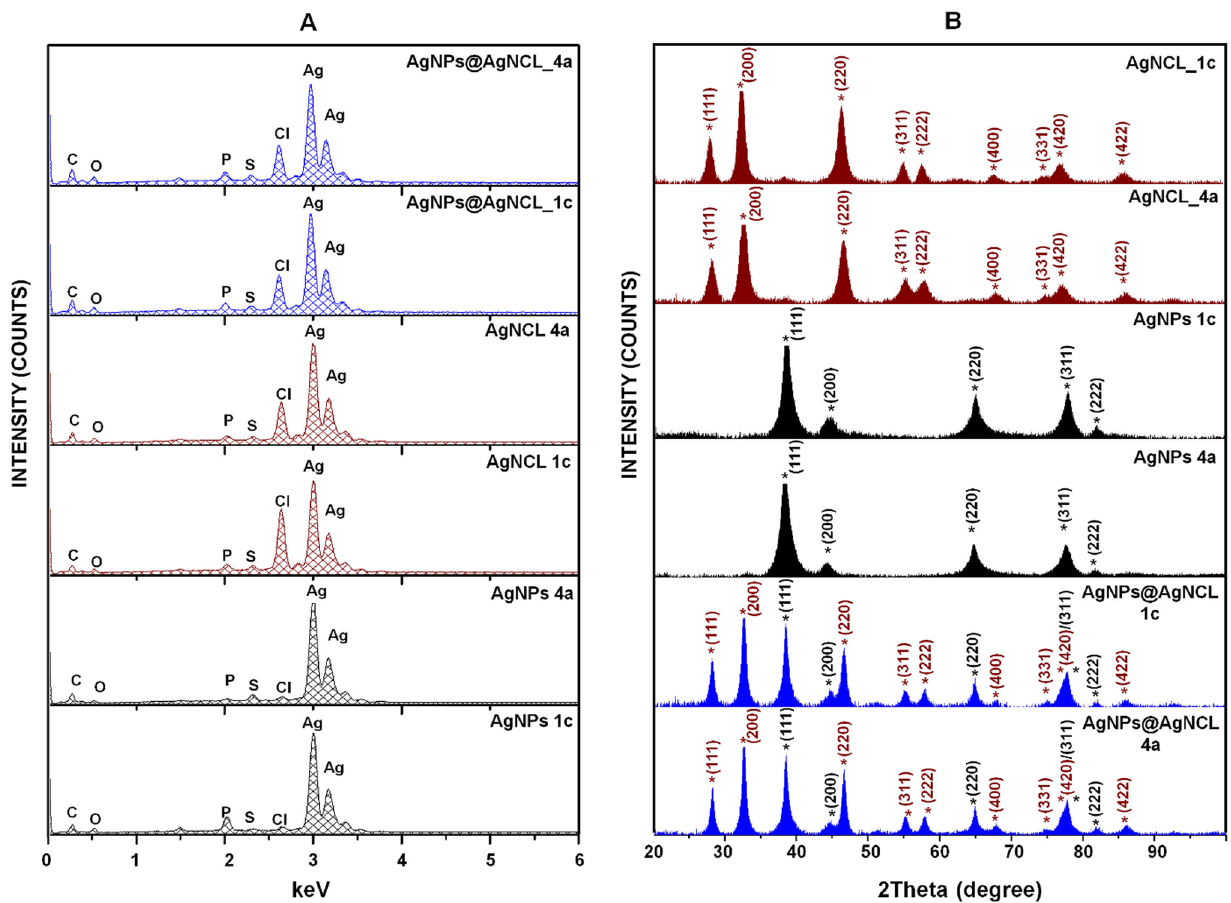
Fig. 3 EDX spectrum presenting the elemental composition ( A ) and XRD pattern of all synthesized (Bio)NCs formulations ( B